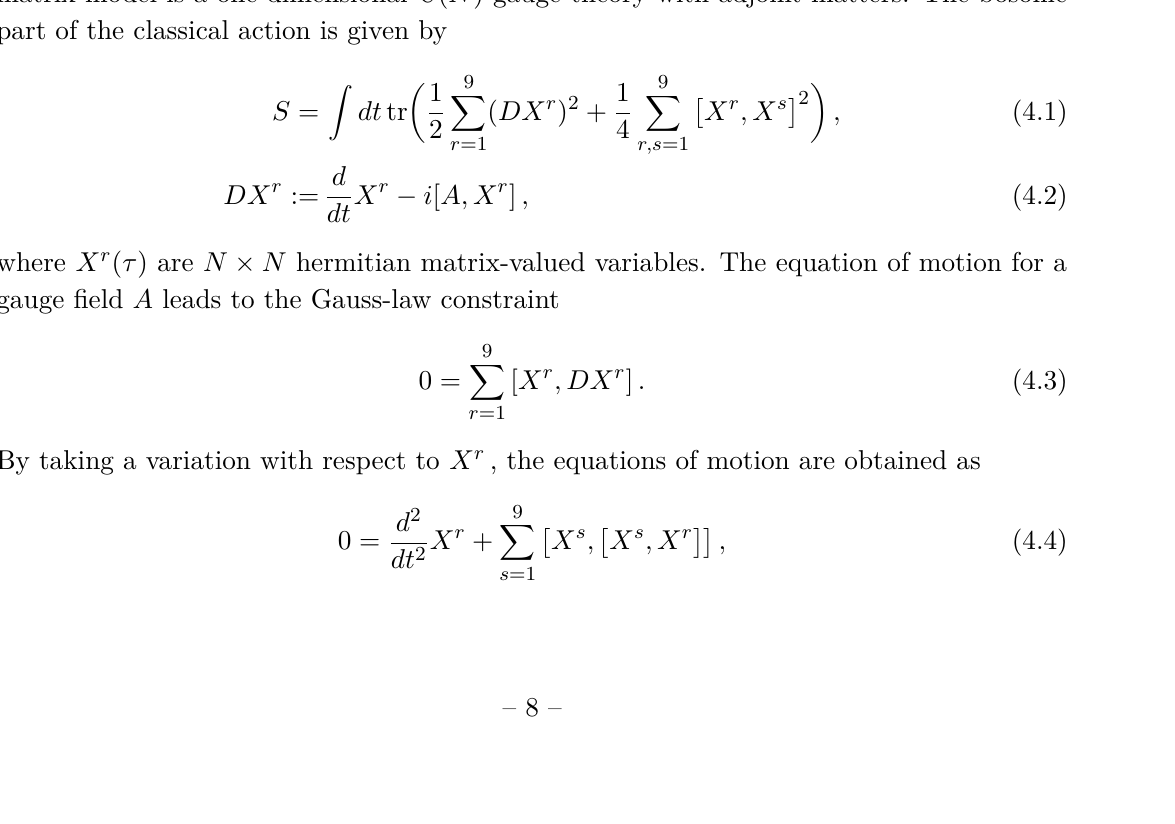
as the fractal dimension d , u